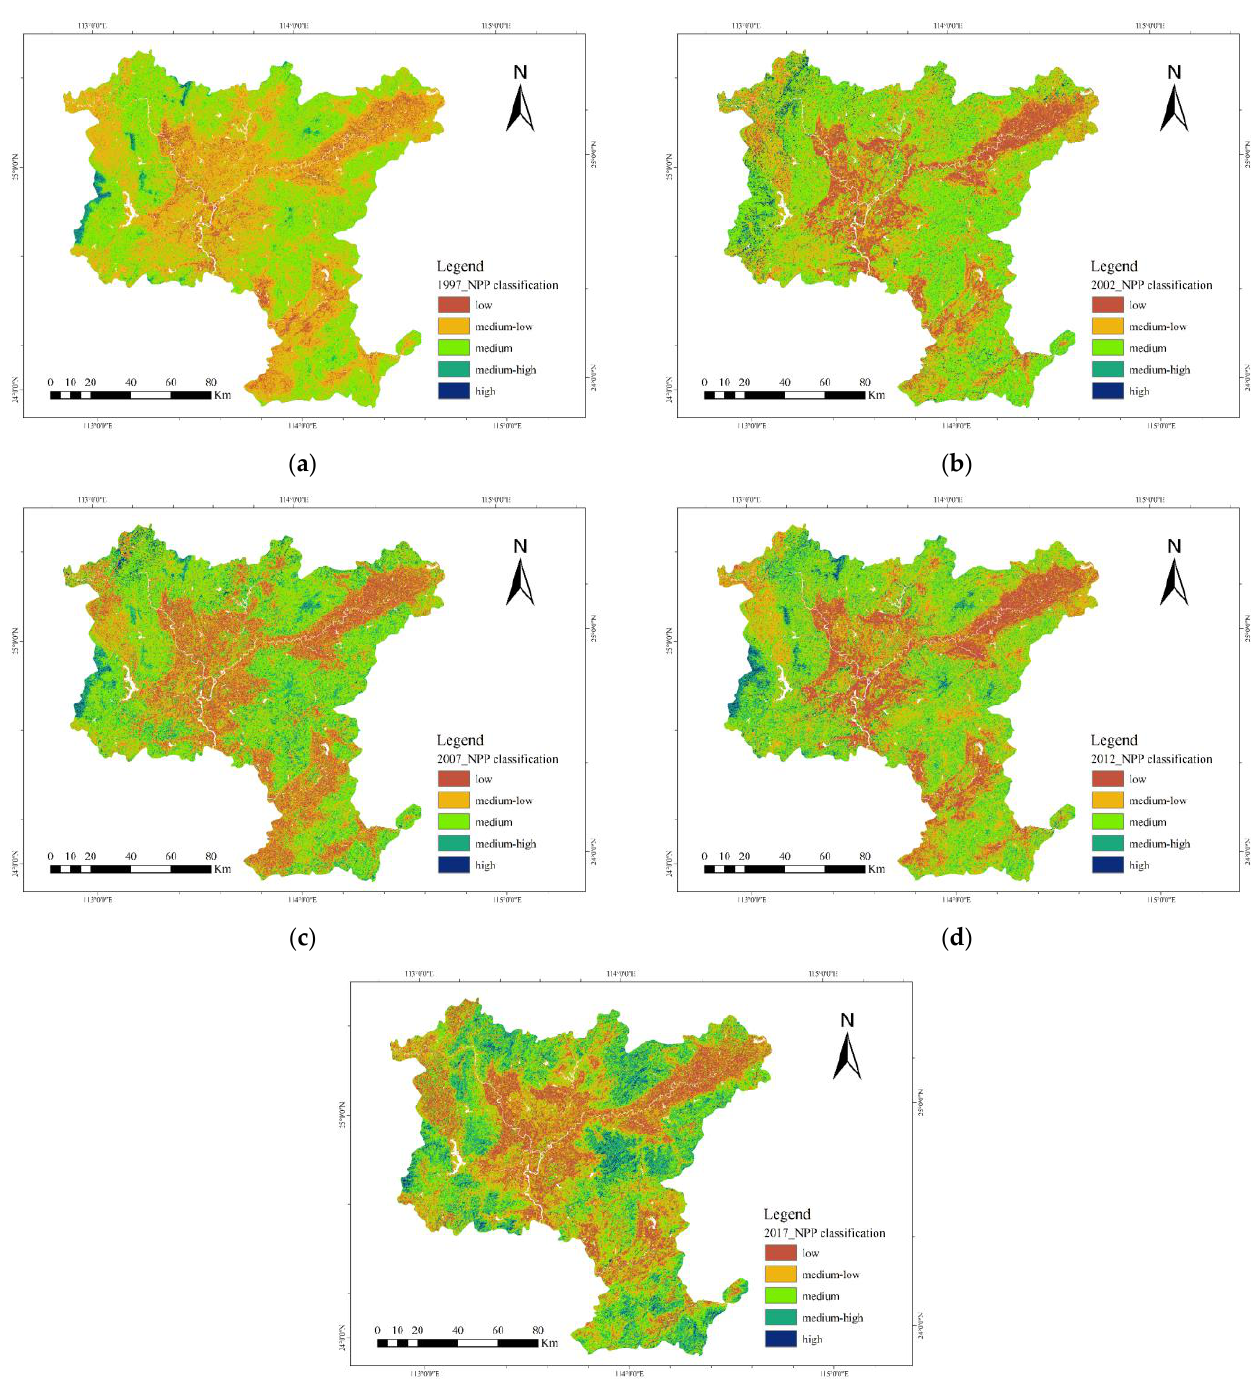
Figure 3. ( a – e ) are the spatial distribution maps of NPP classification in Shaoguan in 1997, 2002, 2007, 2012, and 2017, respectively.